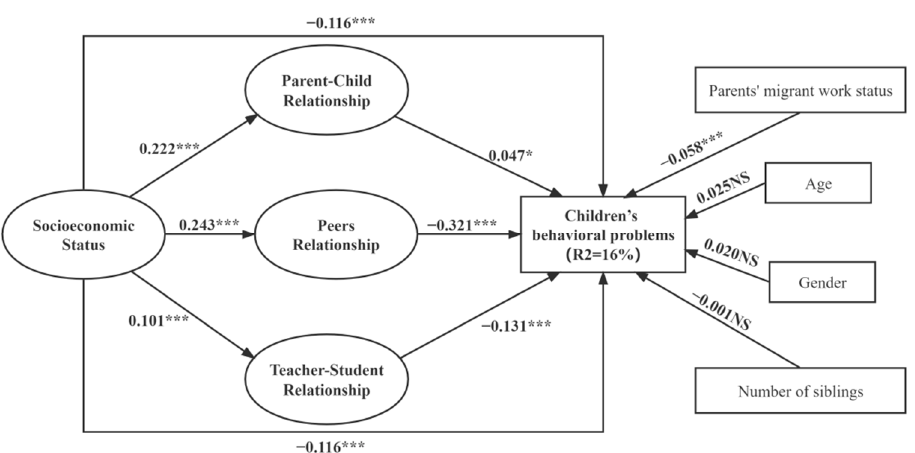
Figure 2. Standardized solutions for the structural model of socioeconomic status, social relations, and behavioral problems in children (*** p < 0.001, * p < 0.1).